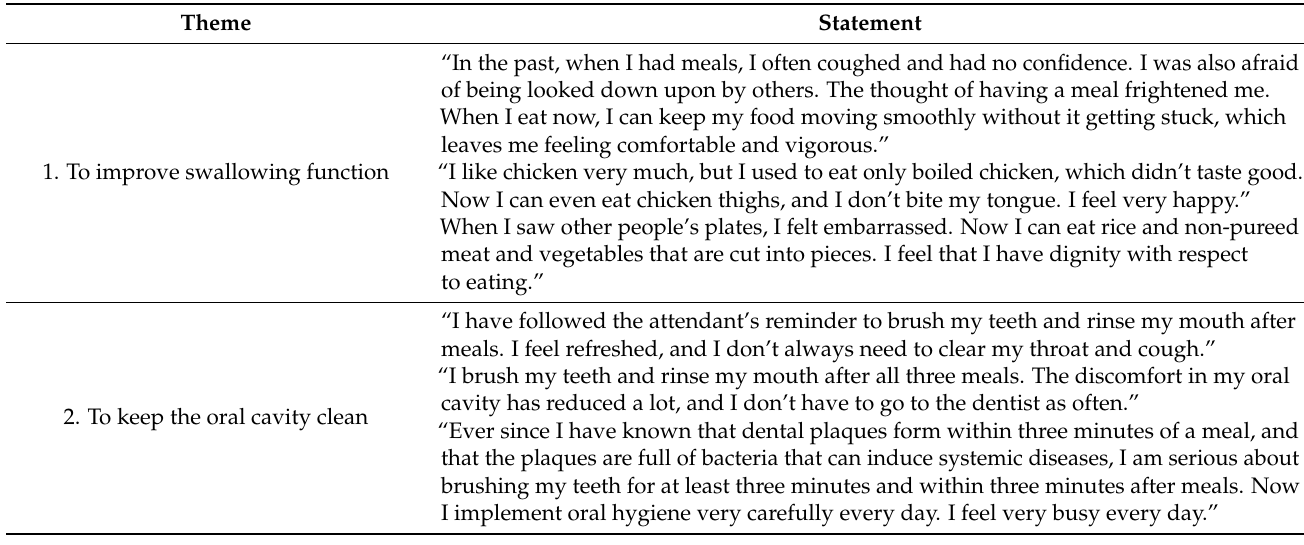
Table 6. Participants’ feedback on the multifaceted intervention